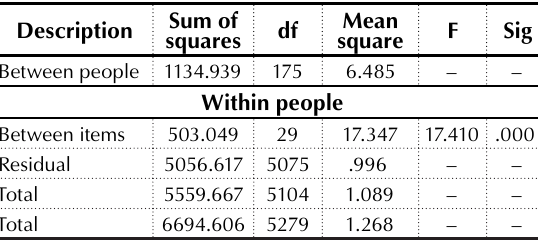
Table 3. ANOVA: Organizational culture